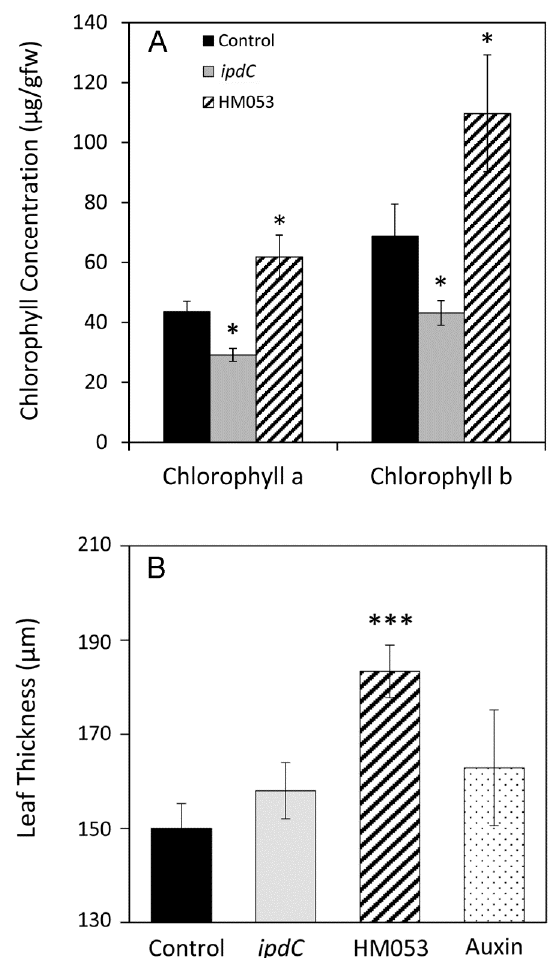
Figure 3. Leaf chlorophyll content and leaf thickness as a function of treatment type. Panel A: The 3-week-old lab plants inoculated with Azospirillum brasilense HM053 showed significant increases in leaf chlorophyll content compared to non-inoculated control plants, while A. brasilense ipdC inoculated plants showed significantly reduced chlorophyll content relative to non-inoculated control plants. Panel B: Leaf thickness measurements carried out at the end of the 2019 growing season showed that plants inoculated with A. brasilense HM053 had significantly thicker leaves compared to control plants. Data reflects N = 12 biological replicates in both panels for each treatment, with error bars indicating ± SE. Paired comparisons were made using the Student t -test between single treatments and non-inoculated control plants. Asterisks indicate significant differences (* p < 0.05, *** p < 0.001) in these comparisons.